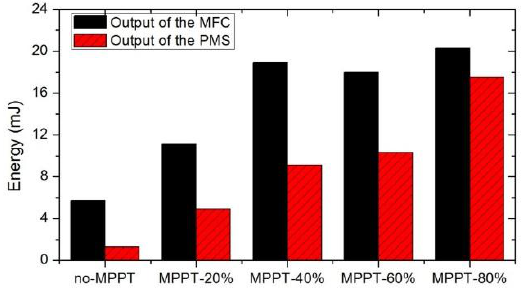
Figure 11. Energy performances in different voltage-ratio configurations.